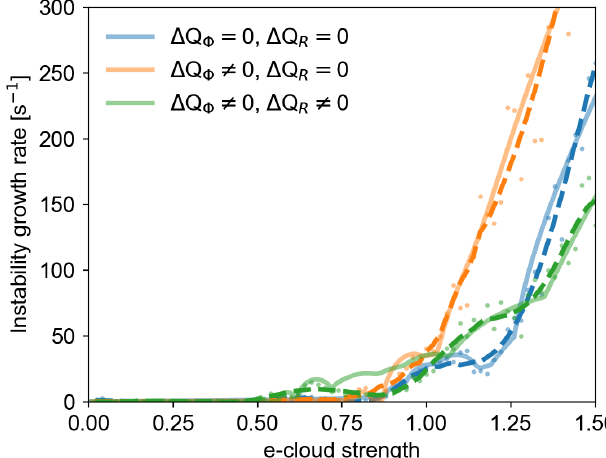
red.FIG. 9. Instability growth rate estimated with the Vlasov method (continuous lines) and with macroparticle simulations using the linearized model (dots). The dashed lines are a smoothed version of the data represented by the